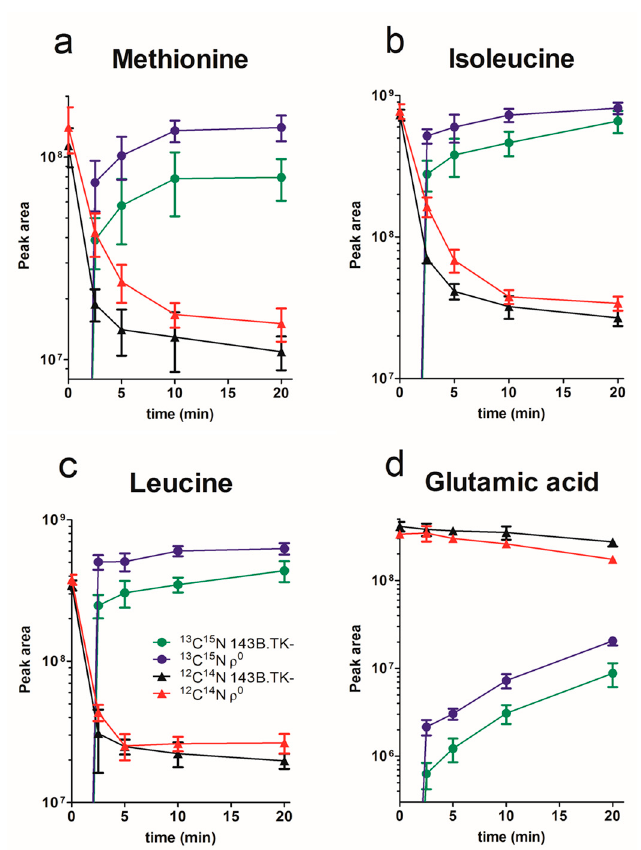
Figure 3. Decrease and increase of significantly regulated amino acids after switching the culture medium from unlabeled to labeled amino acids in ρ 0 and 143B.TK- cells (log10 scale). The peak areas (in counts per second) are shown for ( a ) methionine, ( b ) isoleucine, ( c ) leucine, and ( d ) glutamic acid. 13 C 15 N amino acids of 143B.TK- cells are shown in in green circles, 13 C 15 N amino acids of ρ 0 cells in blue circles, 12 C 14 N amino acids of 143B.TK- cells in black triangles, and 12 C 14 N amino acids of ρ 0 cells in red triangles. Data were expressed as mean and standard deviation (mean ± SD; n = 6).